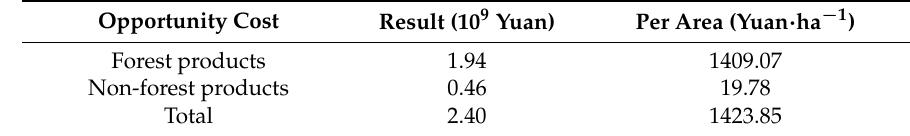
Table 7. Opportunity cost of public welfare forest in Yanqing District in 2014.